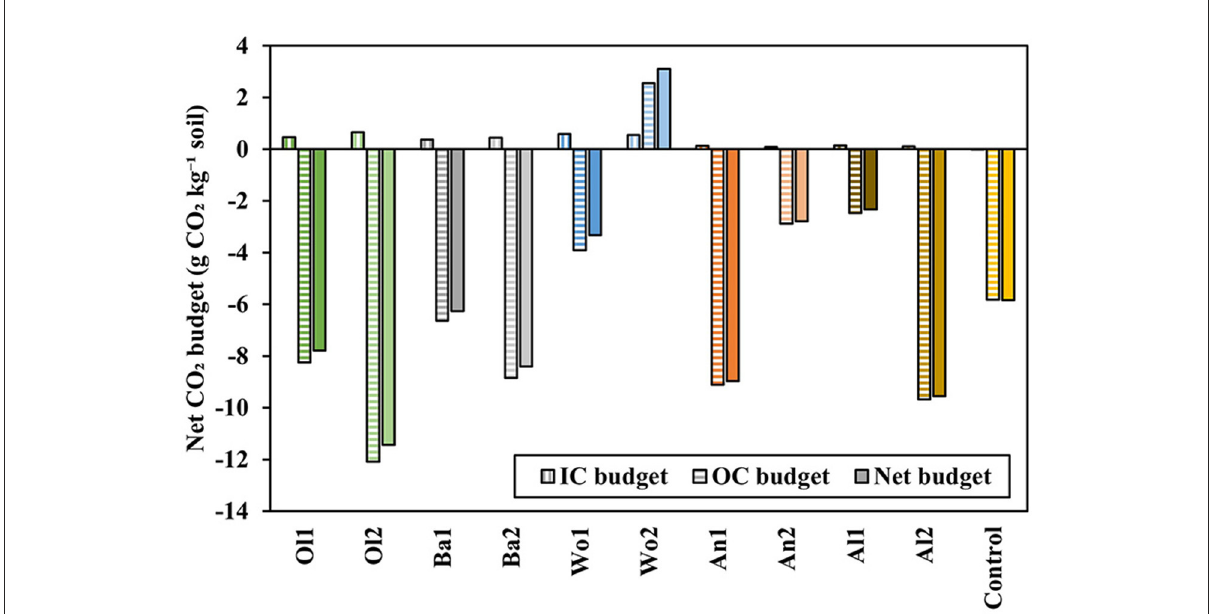
FIGURE9 Net CO 2 budgets (Equation 4). Positive values indicate CO 2 sequestration. Negative values indicate CO 2